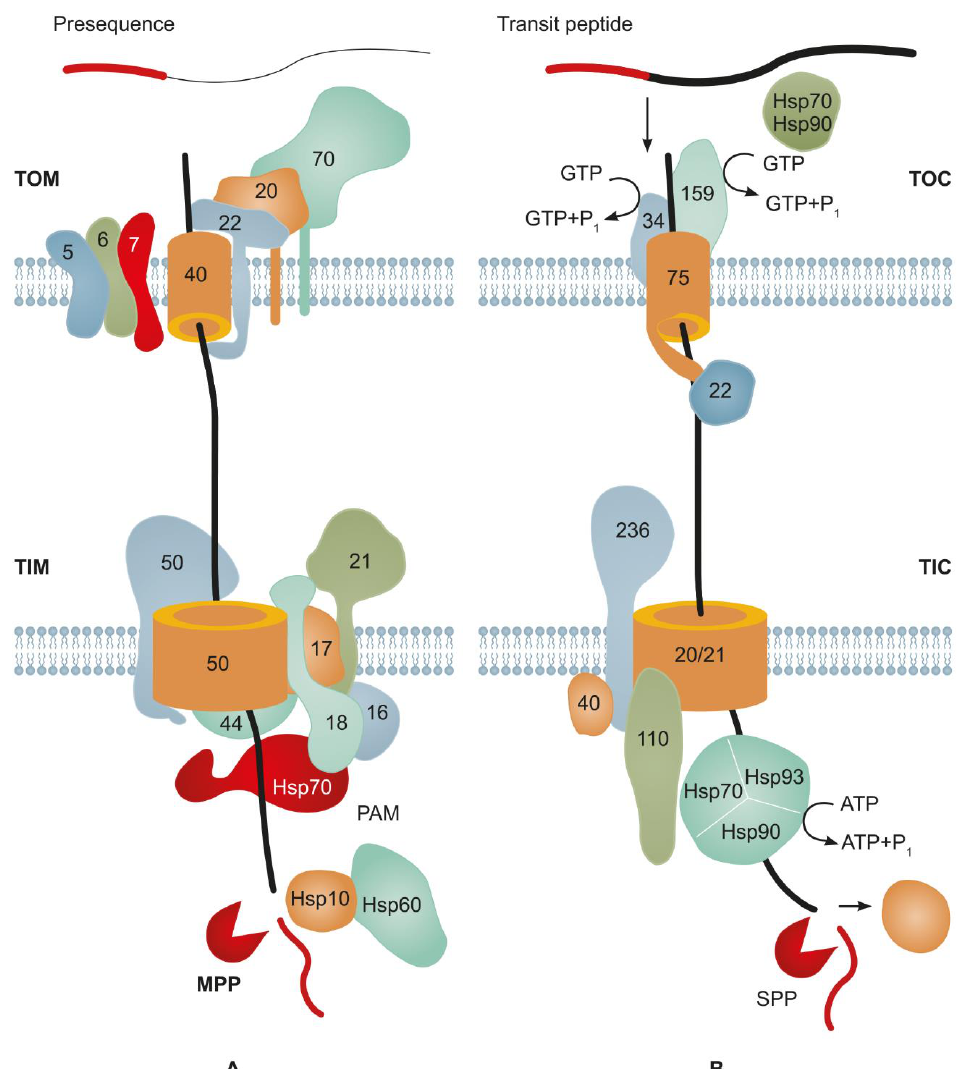
Figure 3. Mitochondrial and chloroplast protein import machineries. ( A ) Mitochondrial transmem- brane protein transport. TOM, translocon of the outer mitochondrial membrane; TIM, translocase of the inner mitochondrial membrane; PAM, presequence translocon-associated motor; and MPP, mitochondrial processing peptidase. Approximate molecular weights (kDa) are indicated on individ- ual TOM, TIM, and PAM components. See the main text for mechanistic details (adapted from [135], with permission). ( B ) Core components of TOC–TIC import machinery of chloroplasts. A newly synthesized preprotein is targeted to the TOC complex at the outer membrane by the binding of its transit peptide to receptors Toc34 and Toc159 with GTPase activities. The targeting is aided by the cytosolic chaperone complexes of Hsp70 and Hsp90. The GTPase activity of the receptors is required for the transport of the preprotein through the TOC and TIC transmembrane channels formed by TOC75 and TIC20/21, respectively. The TOC–TIC supercomplex assembled through the binding of Tic236 to Toc75 and of Tic110 to the TIC complex facilitates the direct transport of the preprotein from the cytosol to the chloroplast stroma. Tic110 and Tic40 (40), together with the chloroplast chaperones Hsp70, Hsp93, and Hsp90, form the ATP-dependent protein motor performing import into the chloroplast stroma. After the import, the transit peptide is cleaved by stromal processing peptidase (SPP) (adapted from [159], with